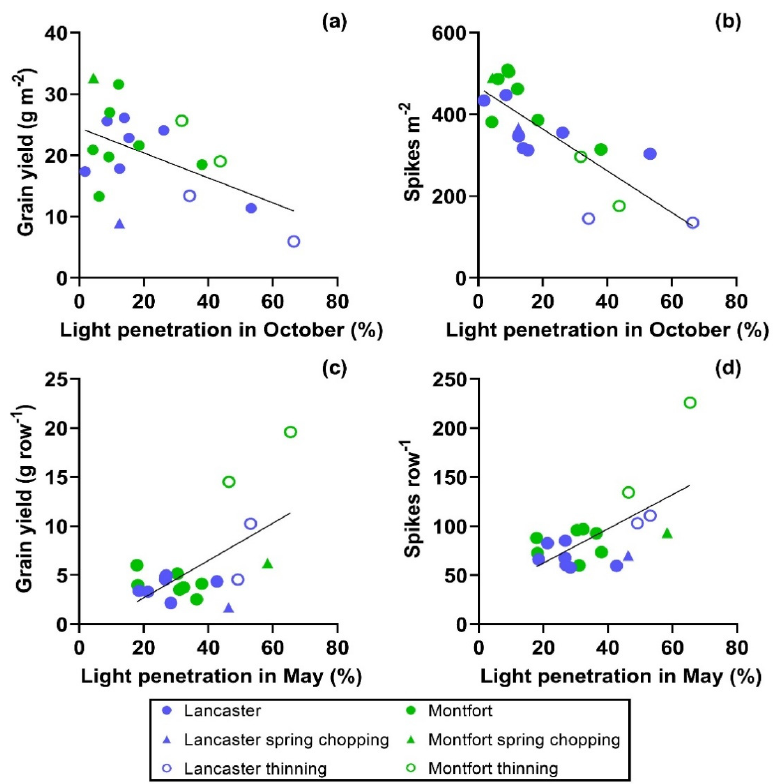
Figure 3. Relationship of the grain yield ( a ) and the number of spikes ( b ) per area in August 2019 as a function of the percentage of light penetration in October 2018, and the grain yield ( c ) and the number of spikes ( d ) per row in August 2019 as a function of the percentage of light penetration in May 2019. In all the panels, each symbol corresponds to the mean for each treatment in Lancaster (blue) or Montfort (green), the empty circles correspond to the treatments which combined resi- due-exported with mechanical or chemical thinning, the filled triangles correspond to residue- exported and spring chopping, and the filled circles correspond to the other treatments.